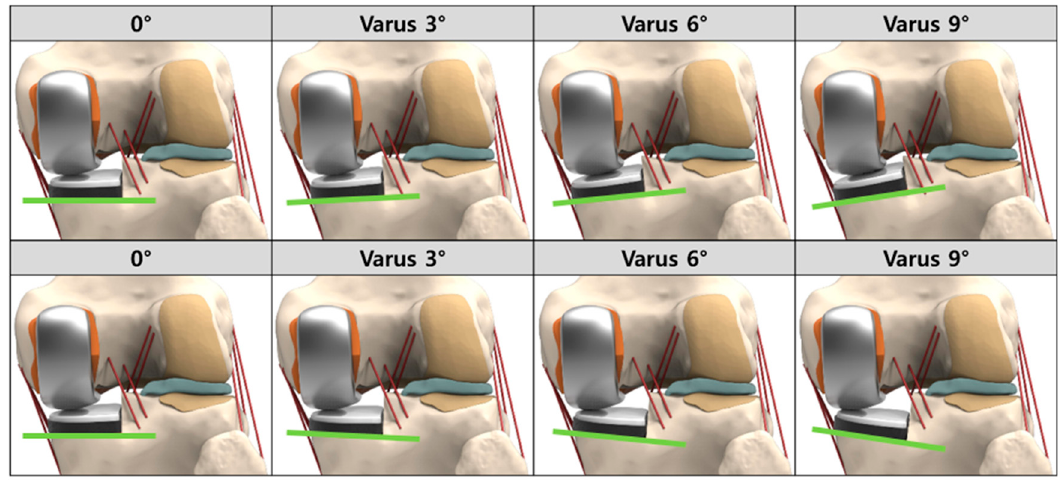
Figure 2. Schematic of varus / valgus conditions for tibial insert.